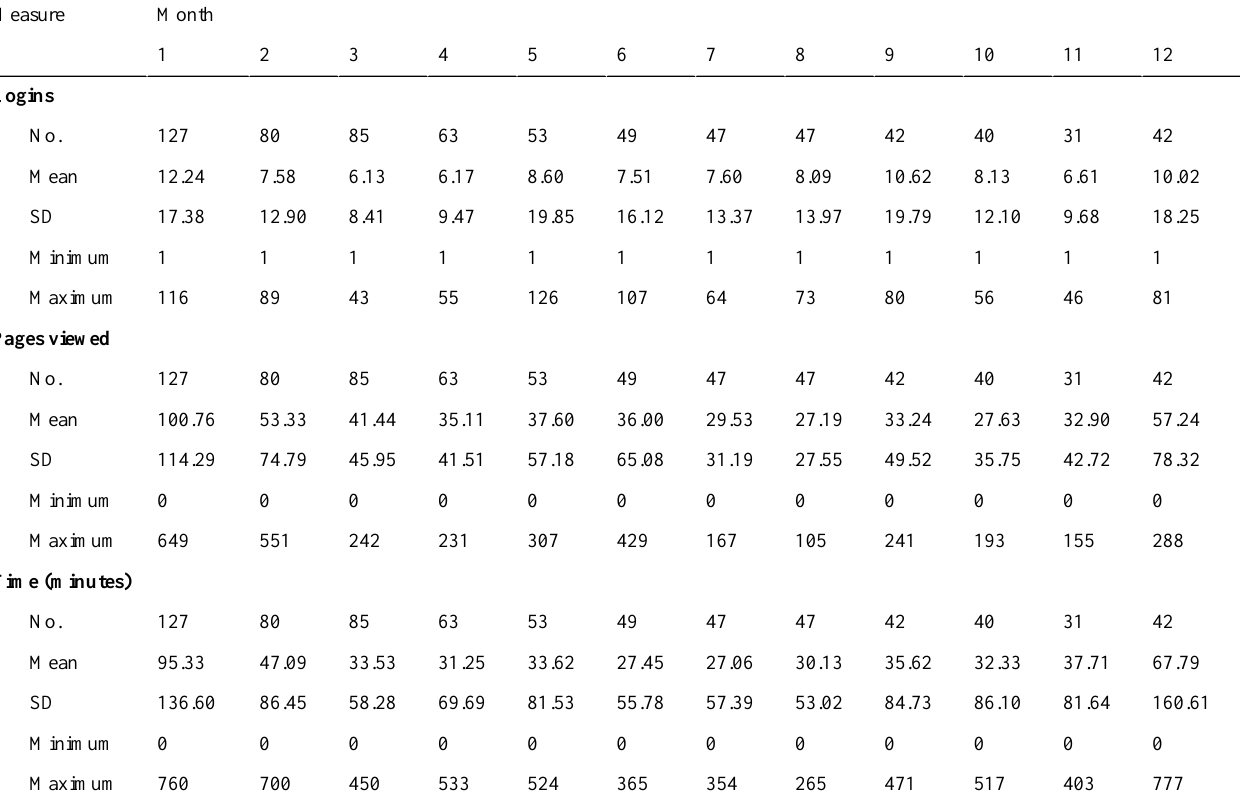
Table 5. Logins, pages viewed, and time spent for actual users who logged into the Comprehensive Health Enhancement Support System (CHESS) each month.